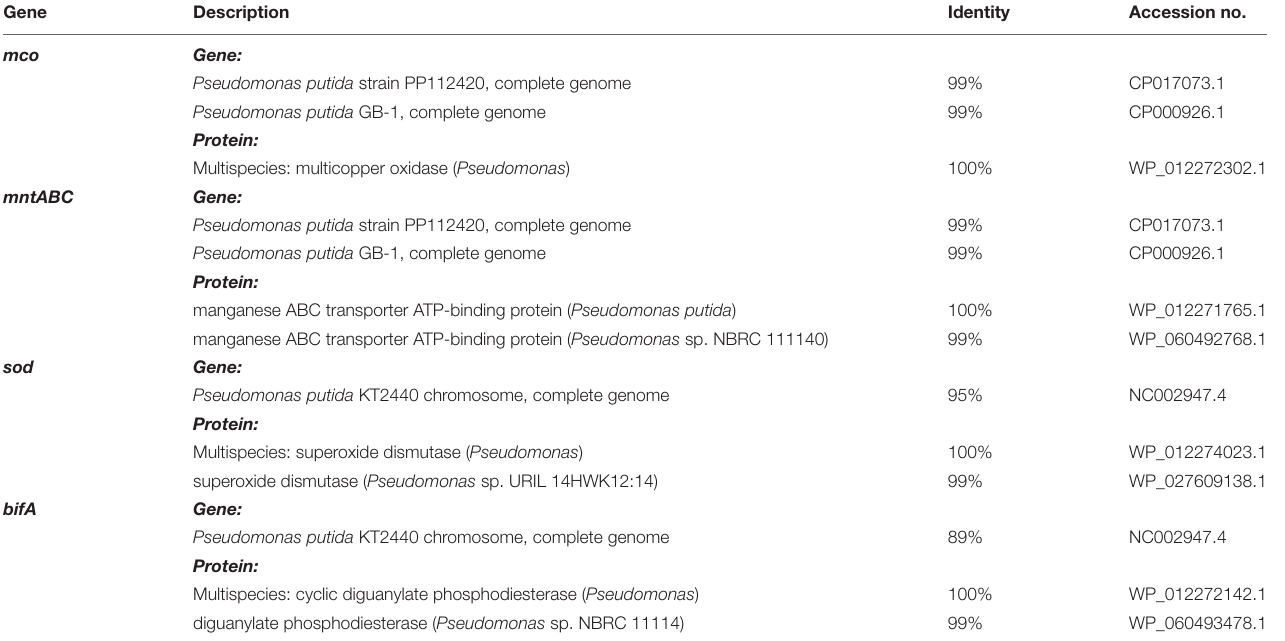
TABLE 2 | The sequence similarity for the amplified PCR products by NCBI